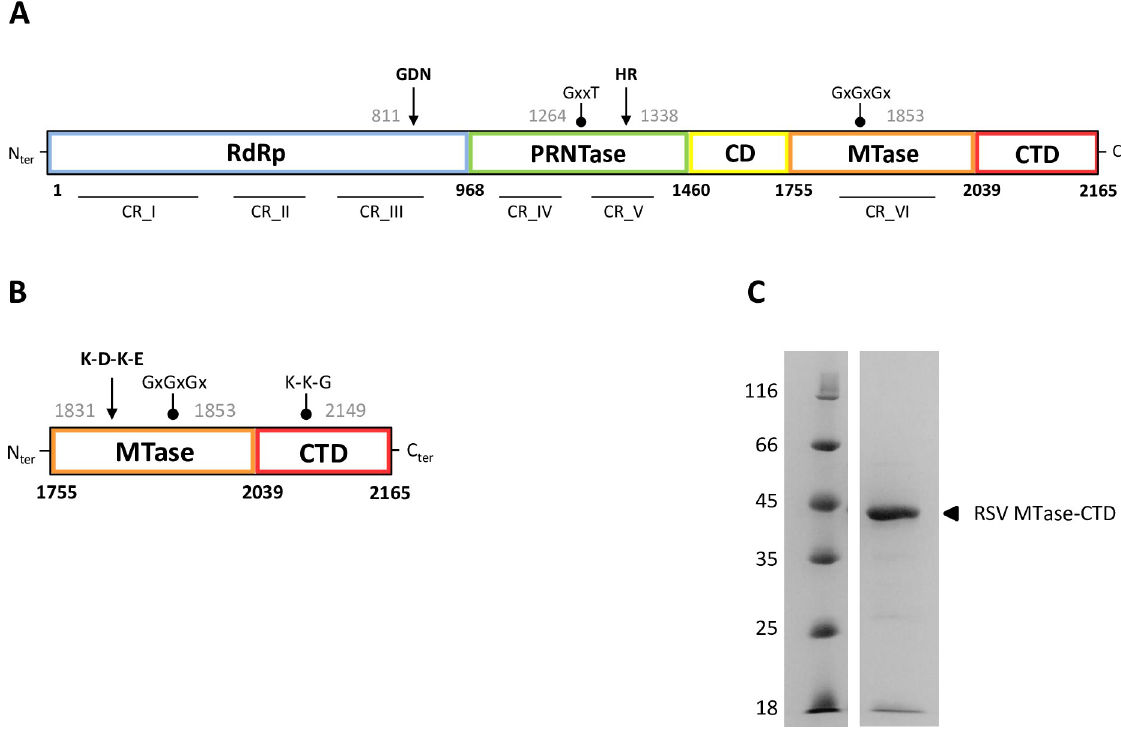
Fig 2. The recombinant RSV MTase-CTD protein. ( A ) Schematic representation of the domain organization of the RSV L protein. Blue, RNA-dependent RNA-polymerase (RdRp) domain; green, polyribonucleotidyl-transferase (PRNTase) domain; yellow, connector domain (CD); orange, methyltransferase (MTase) domain; red, C-terminal domain (CTD). Amino acid residue numbers indicate the functional domain boundaries. The conserved regions (CR) within the L proteins of non-segmented negative-strand RNA viruses are indicated. Arrows denote the position of active site residues required for function, and dots indicate conserved motifs with the starting amino acid residue number in gray. ( B ) The RSV MTase-CTD fragment was defined based on the alignment with the VSV L protein. Arrow indicates the K 1831 - D 1936 -K 1973 -E 2004 catalytic tetrad, typical of 2’- O -MTases. Dots indicate conserved motifs with the starting amino acid residue number in gray: the GxGxGx SAM/SAH binding site motif in the MTase domain, and the K-K-G motif, reminiscent of eukaryotic GTases, in the CTD domain. ( C ) SDS-PAGE of the purified recombinant RSV MTase-CTD protein containing an N-terminal histidine tag (49.3 kDa). Molecular weights (in kilodaltons) of the ladder are shown on the left, and the MTase-CTD band is labeled on the right.